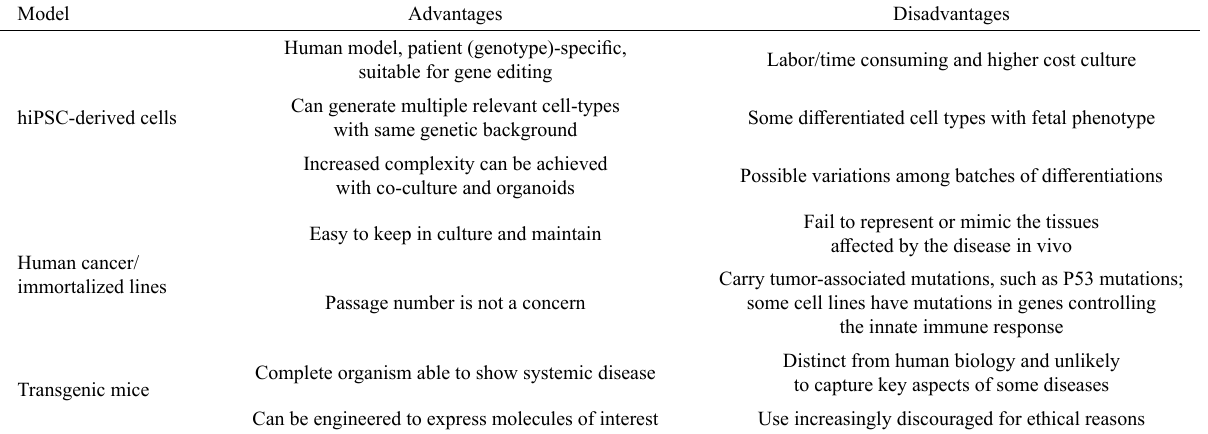
Table 1 – Advantages and disadvantages of the different models used for drug